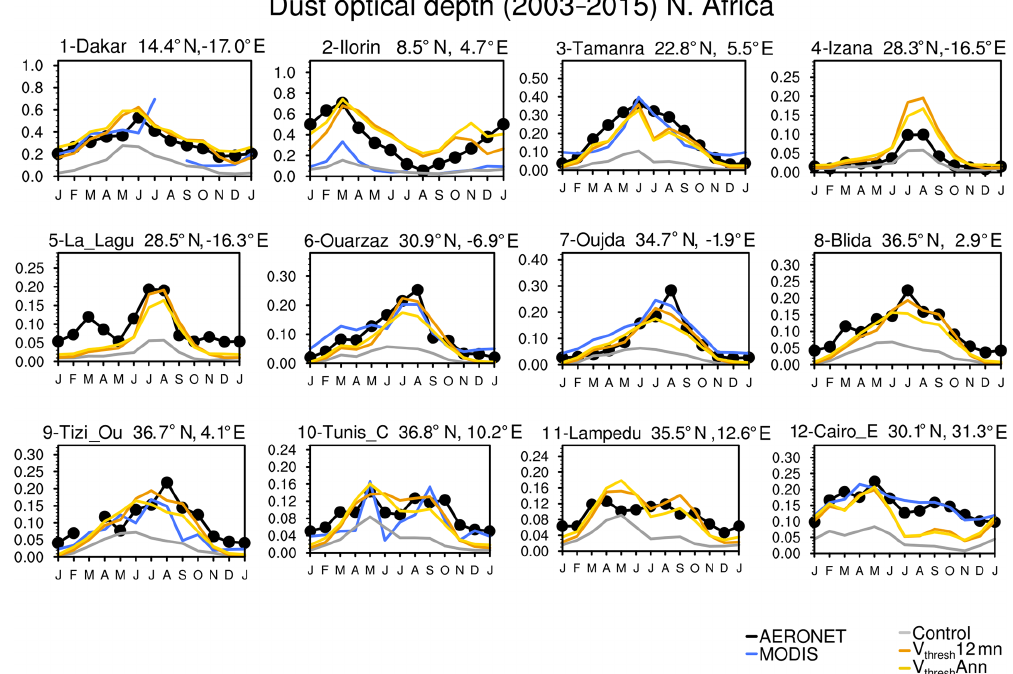
Figure 12. Seasonal cycle of DOD over 12 AERONET SDA sites (see Fig. S7 in the Supplement for locations) from the Control (grey), V thresh 12mn (orange), and V thresh Ann (yellow) simulations, along with DOD from MODIS (blue) and COD from AERONET (black dotted line). All values are averaged over 2003–2015. The location (coordinates) and the name (due to space, only the first seven characters are shown) of the sites are listed at the top of each plot.